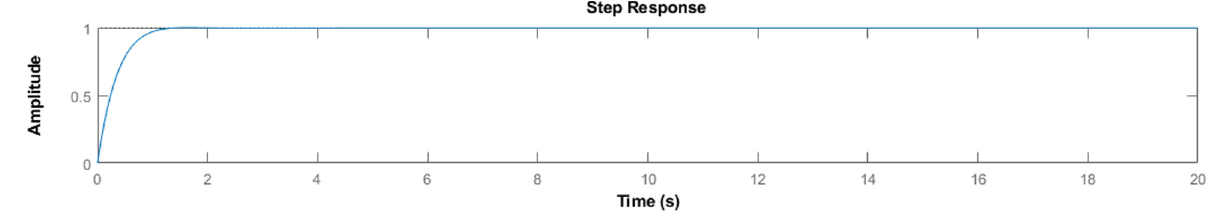
Figure 5. Corrected output response with E FD = 1, P m = 1.